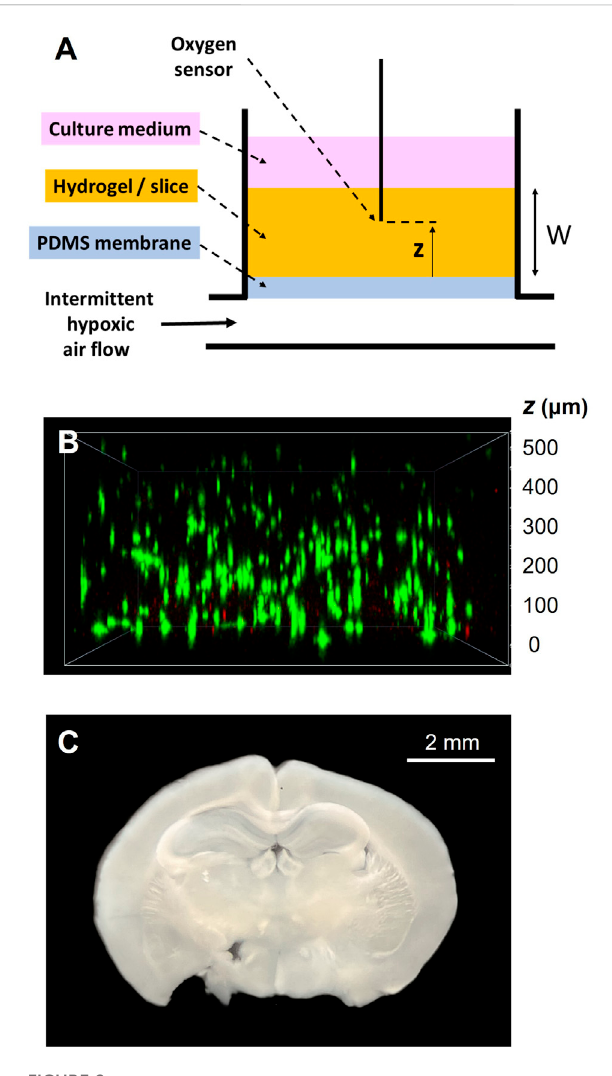
FIGURE 2 (A) Experimental setting for applying intermittent hypoxia to 3D- cultured cells. A culture well has a bottom consisting of a polydimethylsiloxane (PDMS) membrane. The compartment beneath the membrane is circulated with intermittent hypoxic air. The cells tobesubjectedtointermittenthypoxiaareculturedwithina3Dhydrogel or tissue slice of width W placed on the membrane. Only to characterize the setting, a thin fast-response O 2 sensor probe is used to measure O 2 concentrationatdifferentpositions( z )acrossthesample. (B) Example of the achieved distribution of lung mesenchymal stromal cells within a lung ECM hydrogel (20 mg/mL) along the sample thickness, with green and red colors indicating live and dead cells respectively (Live/Dead viability kit; Invitrogen). Reproduced from Reference (Falcones et al., 2021)underCreativeCommons Attribution (CC BY) license. (C) Example of a mouse brain slice to be subjected to intermittent